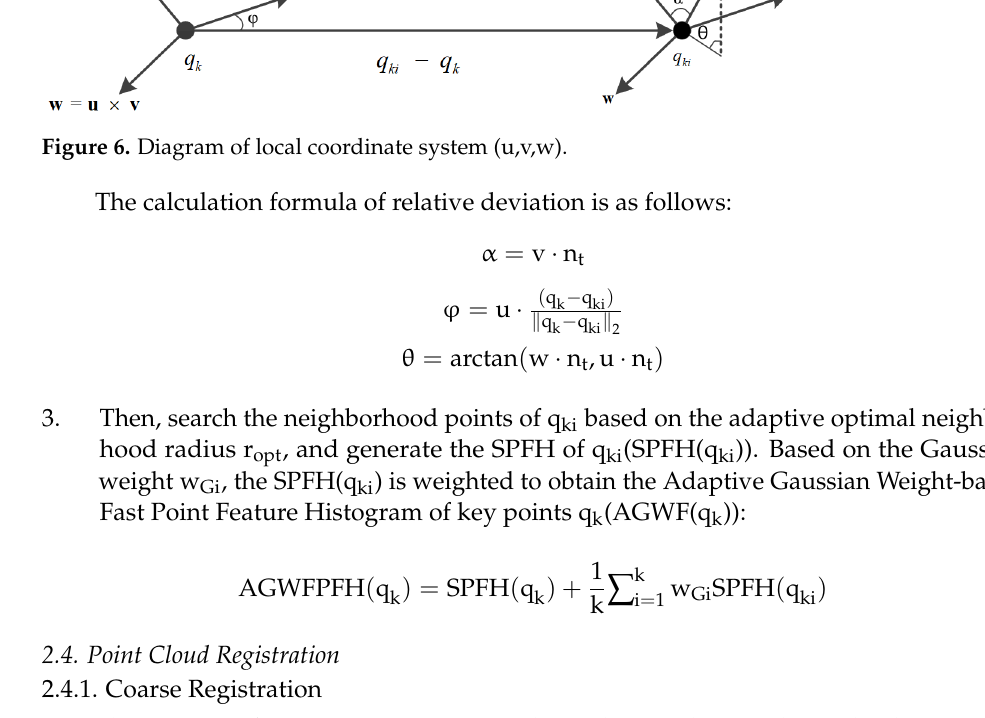
8 of 22 Figure 5. Weight variation trend of neighborhood points of a key point. Combined with the adaptive optimal neighborhood radius selection criterion, an Adaptive Gaussian Weight-based Fast Point Feature Histogram (AGWF) is proposed. It can not only improve the efficiency of feature extraction but also improve the accuracy and robustness; the specific calculation steps are as follows: